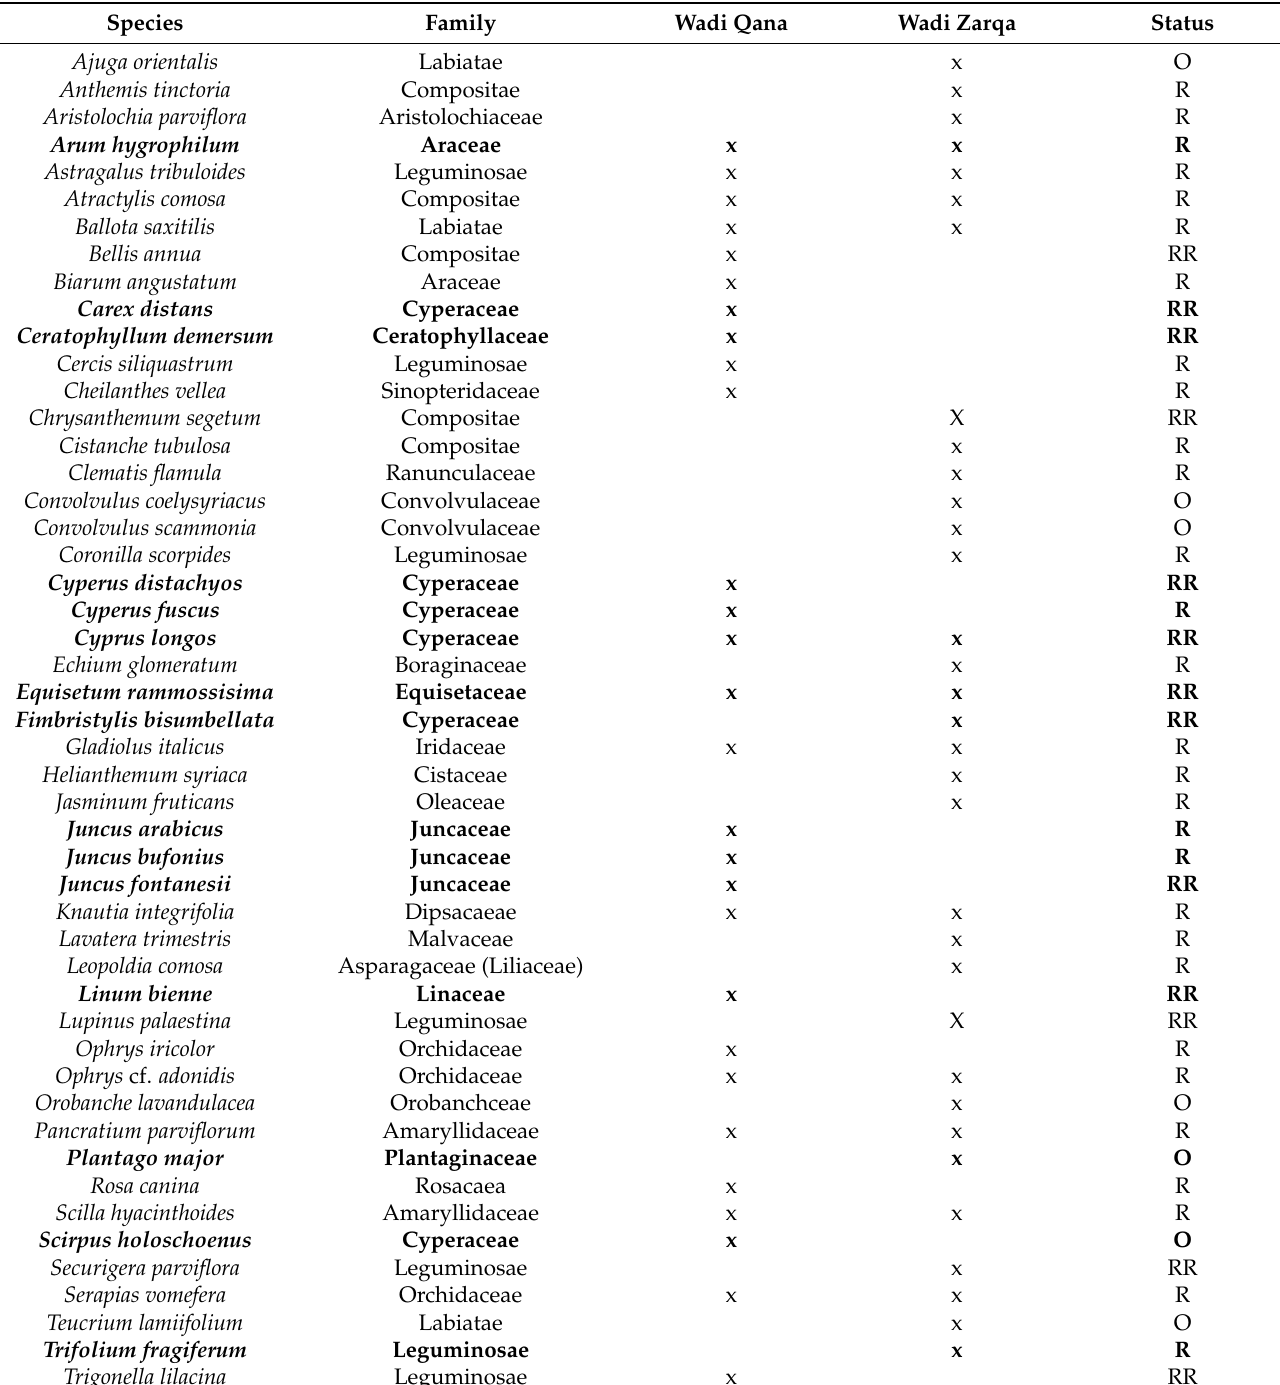
Table 1. Rare Plants in Wadi Qana and Wadi Zarqa shows both similarities and differences in floral composition lf important plants. Status abbreviation: O = Extremely Rare with 1–3 sites in the West Bank, RR = Very Rare (4–10 sites in the West Bank), R = Rare (11–30 sites). In bold, we show hygrophyl (wet-dependent) plants, but these exclude the vernal pools discussed